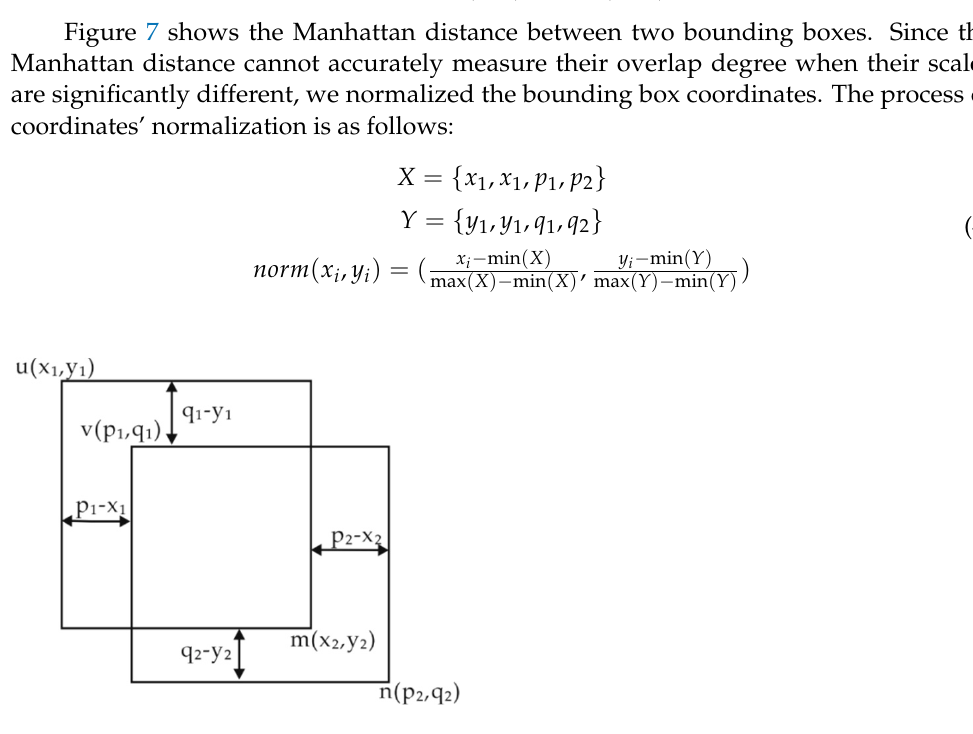
Figure 7. The Manhattan distance between two boxes. u and m are the upper-left and lower-right coordinates of box 1, respectively. v and n are the upper-left and lower-right coordinates of the box 2, respectively.